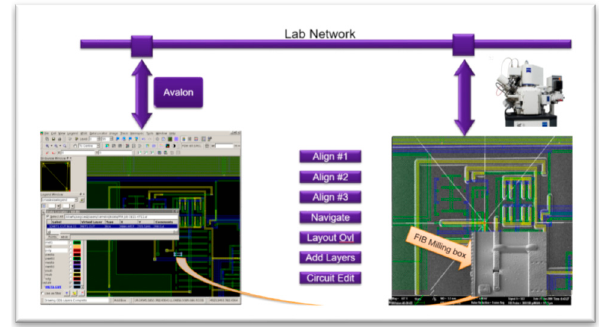
Figure 7. CAD navigation through Avalon and equipment communication.